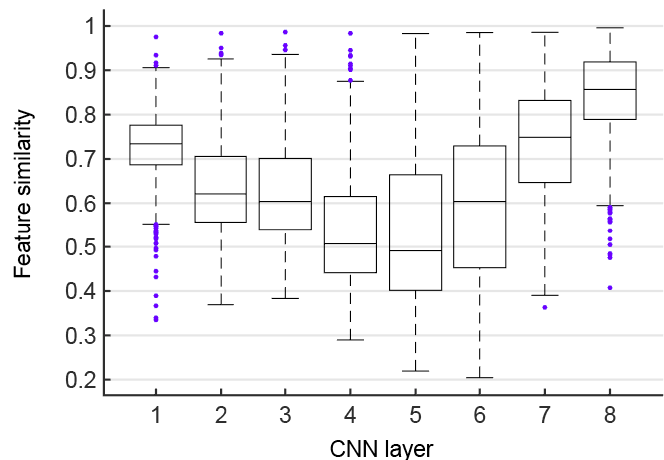
Figure 4. Features similarities. Each box shows feature similarities of a pair of corresponding CNN layers before and after data